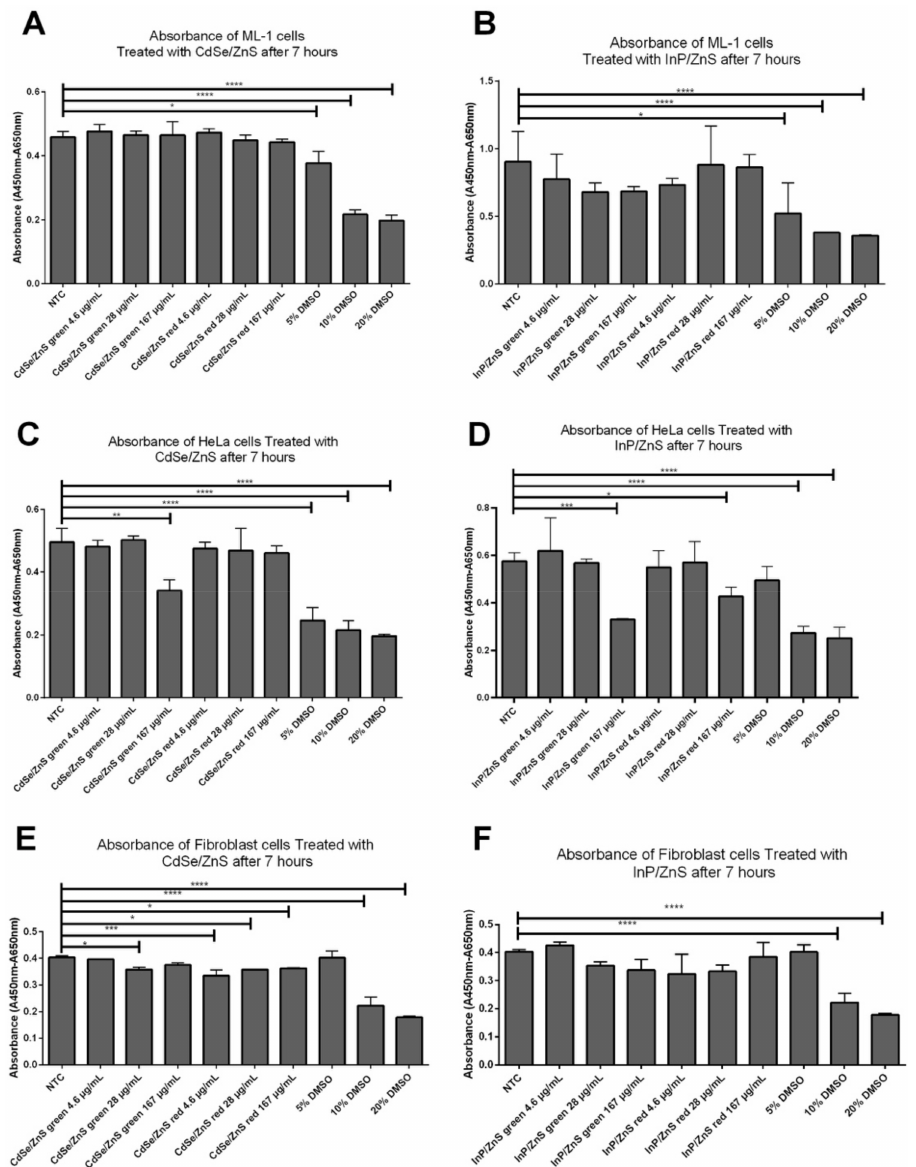
Figure 1. Effects of CdSe/ZnS and InP/ZnS QDs on cell viability in ML-1 and HeLa cell